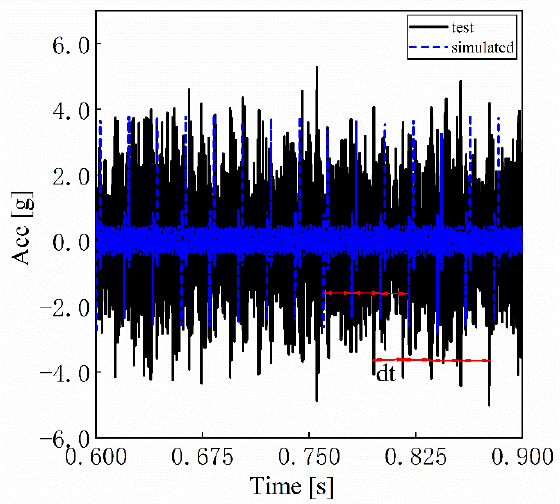
Figure 12. Time domain diagram of vibration acceleration of the helical gear in faulty state.